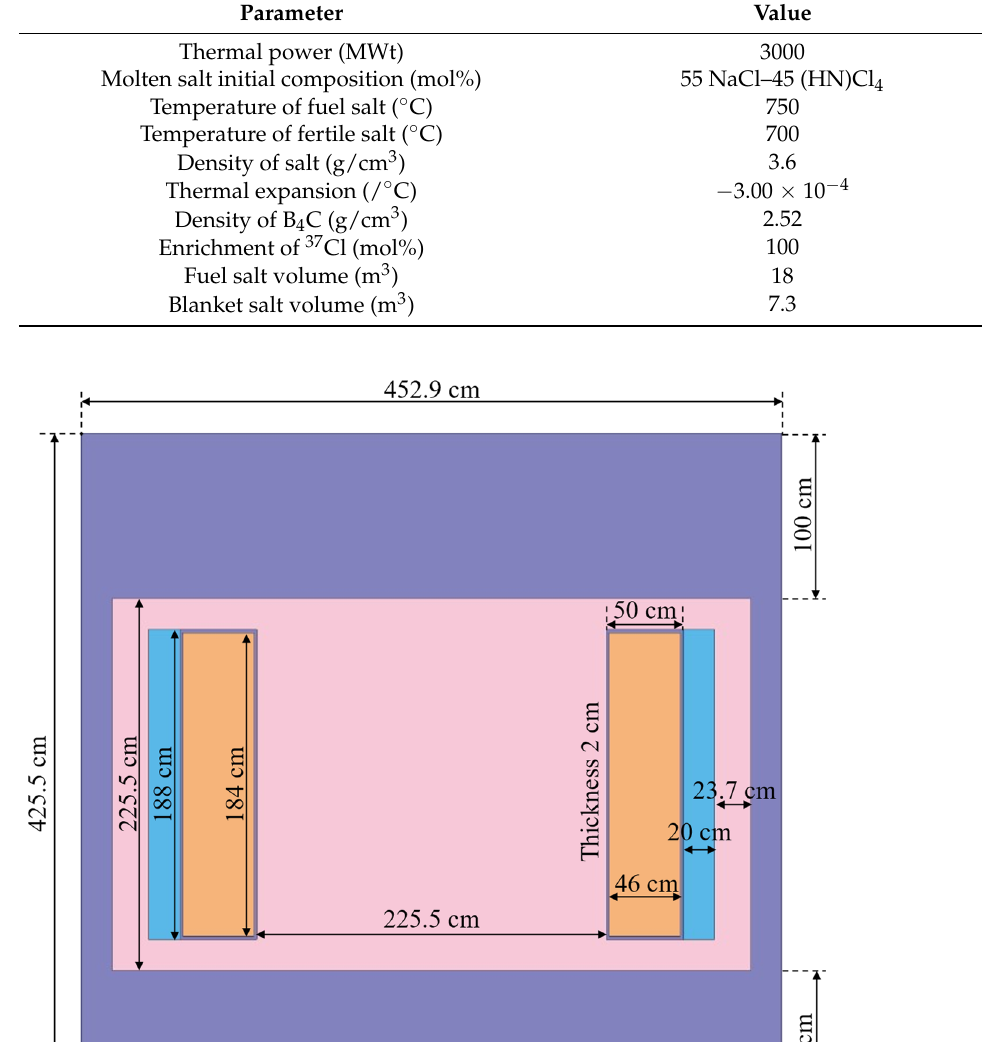
Table 6. Summary of the characteristics of the MCSFR.